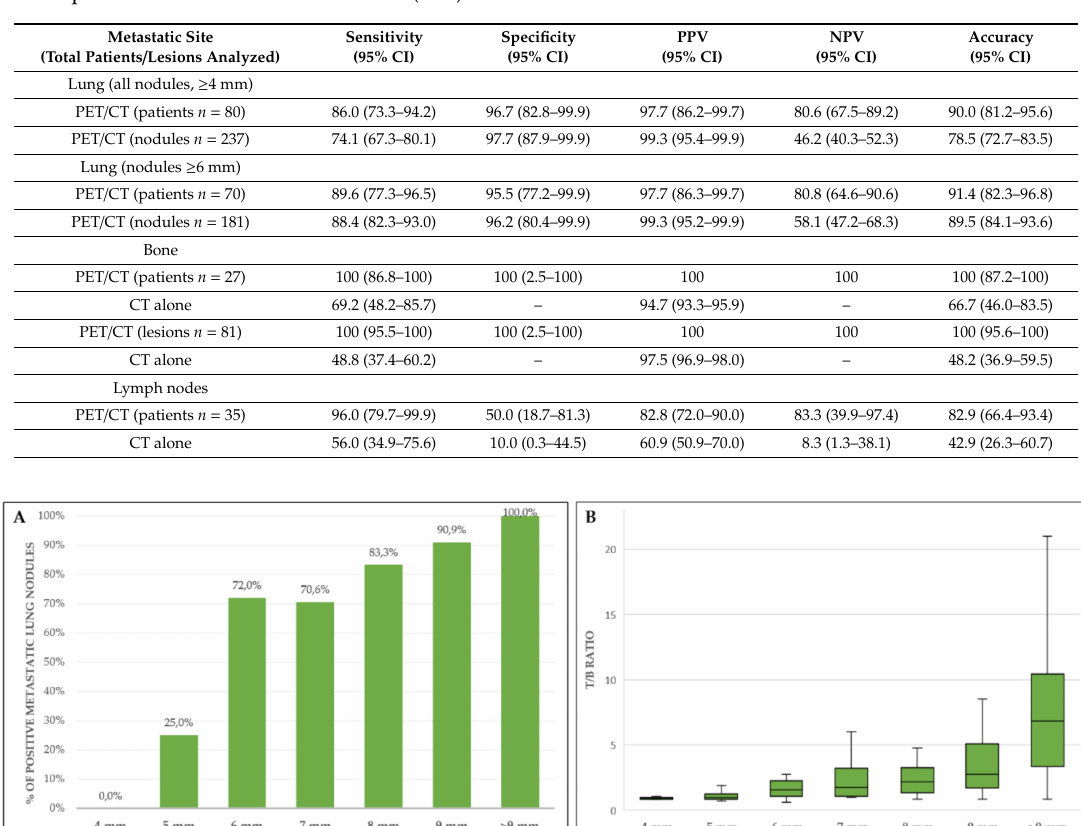
Table 1. Accuracy of 18 F-FDG PET / CT for the detection of distant metastases in the most frequent sites in patients with soft-tissue sarcomas (STS).